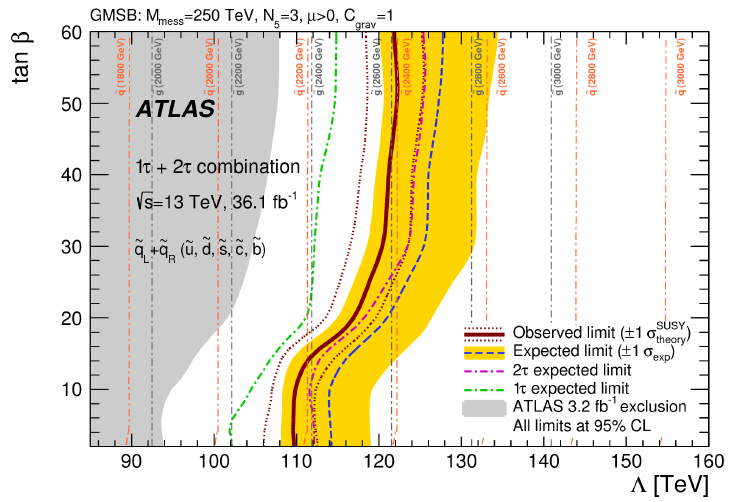
Figure 2: Exclusion contours at the 95% CL as a function of the LSP mass m gluino mass m for the simplified model of gluino pair production [ 4 ] . ˜ g